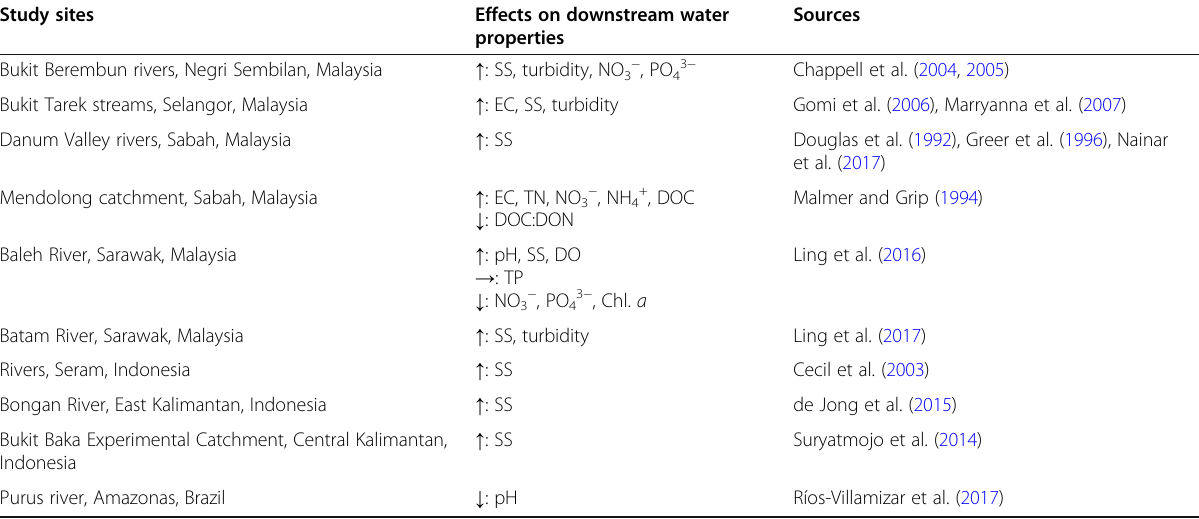
Table 1 A summary of the effects of logging on the downstream riverine and estuarine water properties. The arrows indicate that the subsequent water properties increased ( ↑ ), decreased ( ↓ ), or did not change ( → ). See the list of abbreviations for